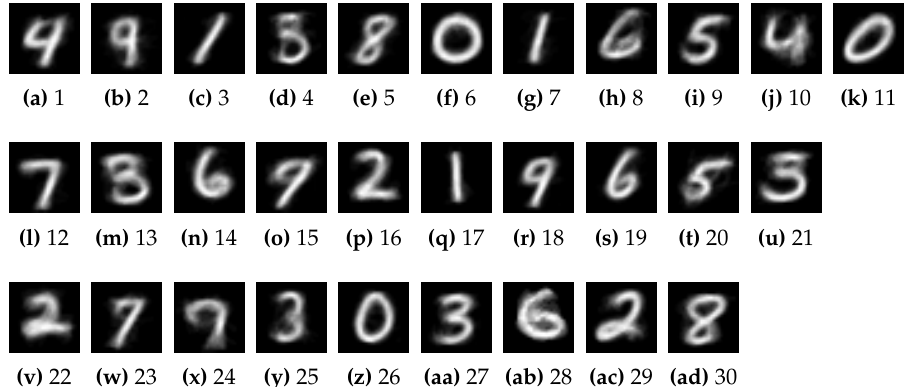
Figure 11. The thirty CRDPs (cluster centers). Each node in layer 1 of Figure 10 acts as the abstract representative of each